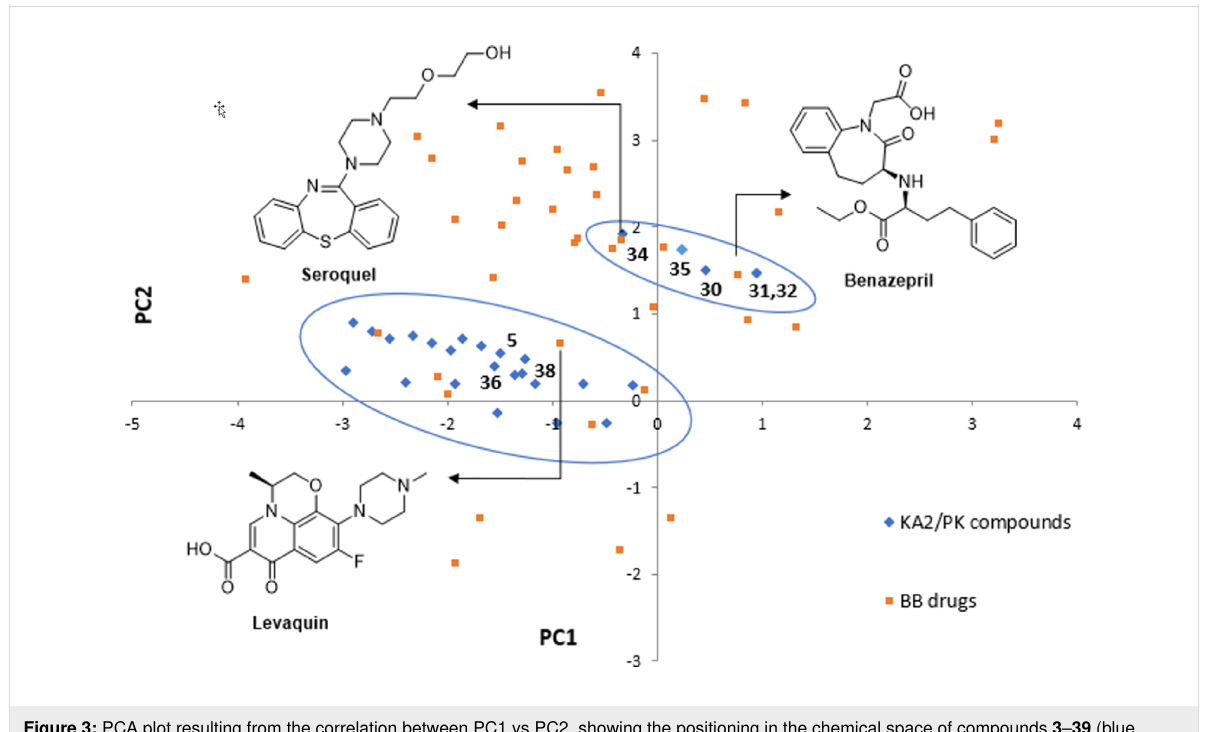
Figure 3: PCA plot resulting from the correlation between PC1 vs PC2, showing the positioning in the chemical space of compounds 3 – 39 (blue diamonds) with respect to the reference set of brand-name blockbuster drugs (orange squares).